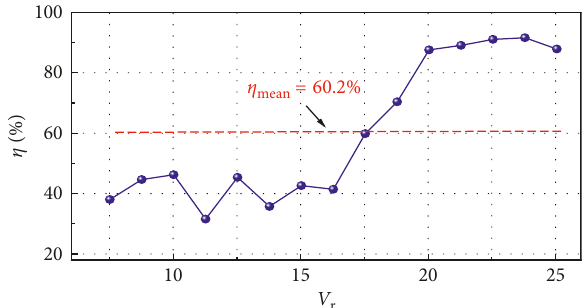
Figure 7: VIV suppression efficiencies of the main vertical flexible cylinder with control rods versus the reduced